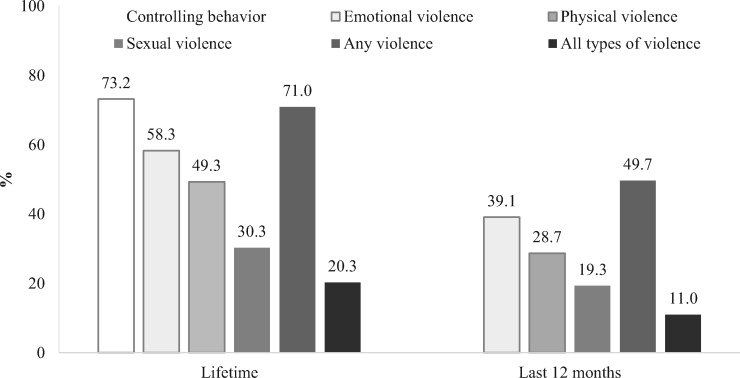
Experiences of IPV in lifetime and in last 12 months